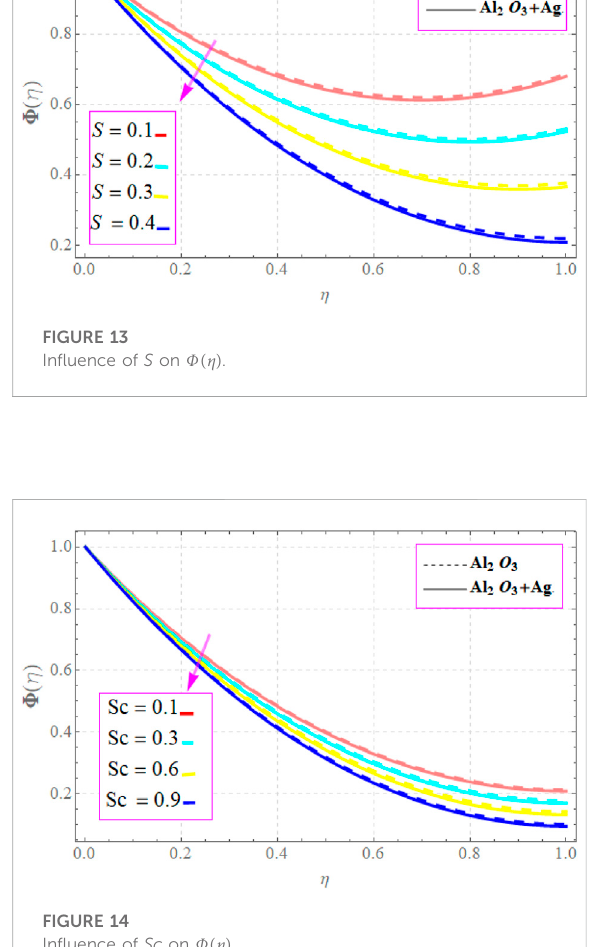
FIGURE 14 In fl uence of Sc on Φ ( η )